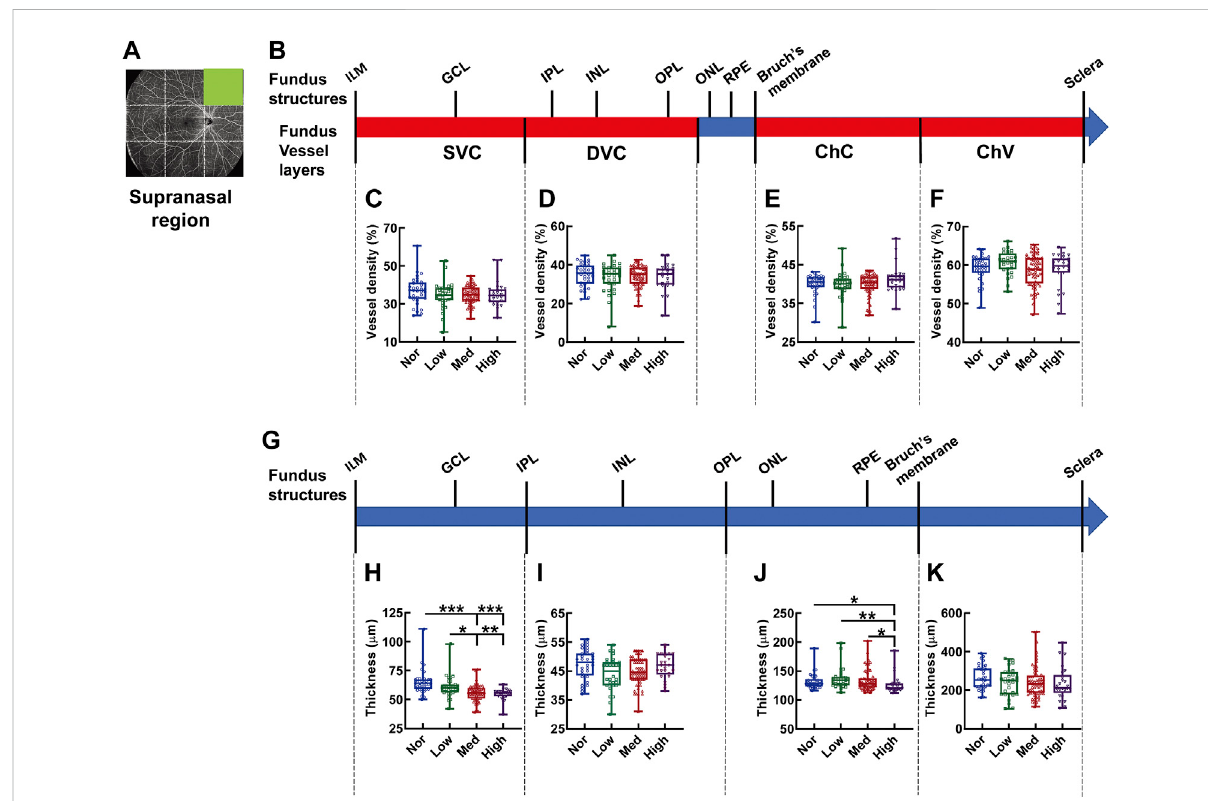
FIGURE 5 Vessel layer densities and structure thicknesses at the supranasal region of the fundus. Position of the supranasal region of the fundus is illustratedin (A) .Schematicillustrationofvessellayersinthefundusisshownin (B) .Vesseldensitiesofsuper fi cialvascularcomplex (C) ,deepvascular complex (D) , choriocapillary (E) , and choroidal vessel (F) layers are quanti fi ed and compared. Schematic illustration of segments in the fundus is shown in (G) . Thicknesses of the segments from IML to IPL (H) , from IPL to OPL (I) , from OPL to Bruch ’ s membrane (J) , and from Bruch ’ s membranetothesclera (K) arequanti fi edandcompared.* p < 0.05,** p < 0.01,*** p < 0.001.SVC,super fi cialvascularcomplex;DVC,deepvascular complex; ChC, choriocapillary layer; ChV, choroidal vessel layer; NOR, normal group; Low, low-myopia group; Med, medium-myopia group;